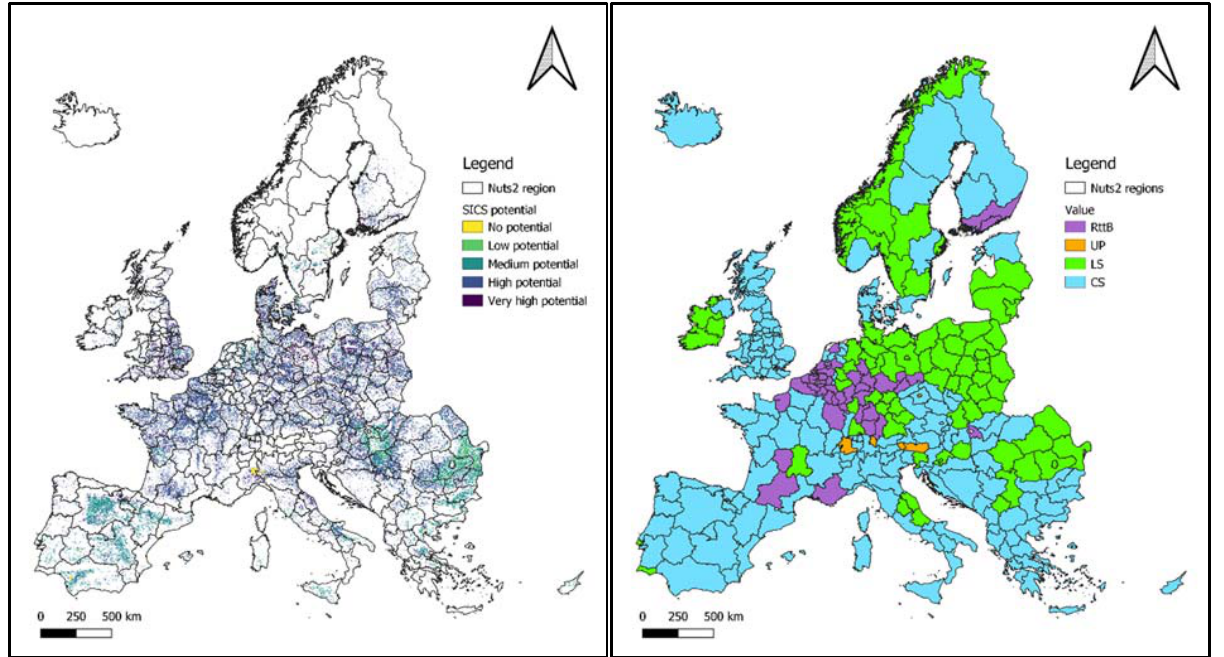
Figure 5. Examples of modelling results. Left: SICS potential index for cover crops (2018) [82]; right: scenarios leading to the highest yield increase in 2050 [81]. RttB = race to the bottom, UP = under pressure, LS = local and sustainable, CS = caring and sharing (see Figure 4).